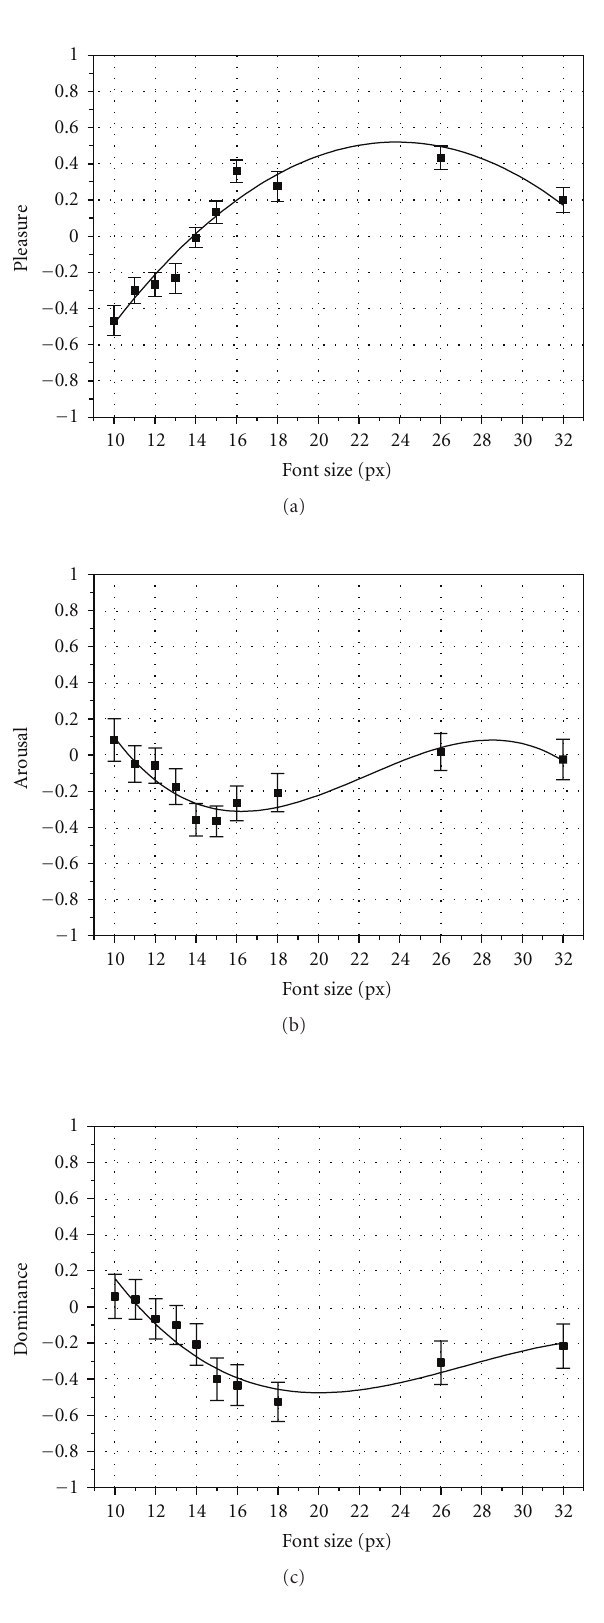
Figure 7: (a) Modeling “Pleasure” versus “Font Size” with (2). (b) Modeling “Arousal” versus “Font Size” with (2). (c) Modeling “Dominance” versus “Font Size” with